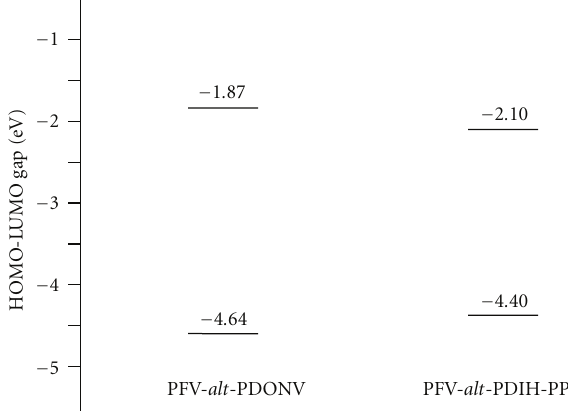
Figure 3: The HOMO and LUMO energies of PFV- alt -PDONV and PFV- alt -PDIH-PPV by